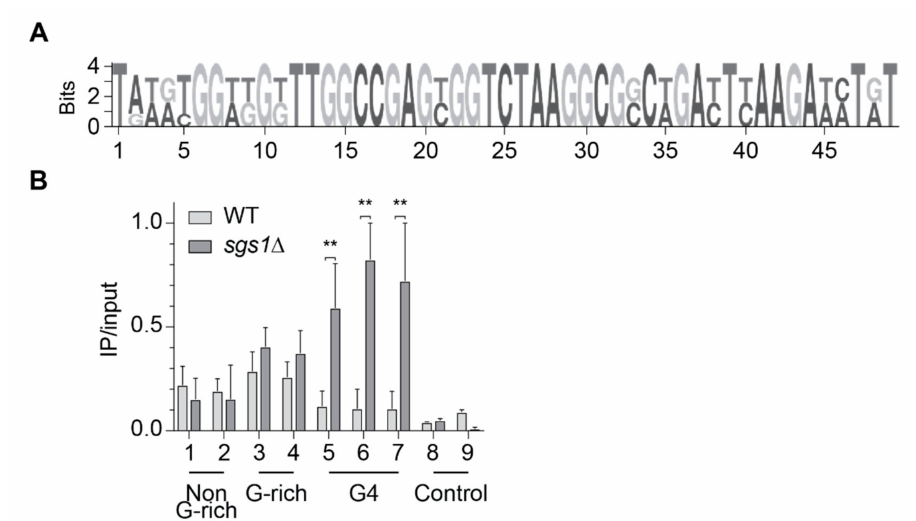
Figure 2. Slx9 binds, genome-wide, to G-rich regions. ( A ) Using Slx9-Myc, two independent ChIP-seq analyses were obtained. Peaks were called using MACS 2.0. A G-rich binding motif was obtained by MEME using the mean of two independent Slx9-Myc ChIP-seq experiments. The binding motif was identified in ~16% of the peaks. ( B ) Slx9 binding was determined to nine endogenous regions (see Supplementary Materials S4 for primer information) by ChIP and qPCR analysis. Selected regions have been identified as binding and non-binding regions in ChIP-seq. Di ff erent sequence compositions were chosen for analysis: non-G-rich (binding) and G-rich (binding) sequences, G4 motifs (no binding), and control regions (no binding). G4 motifs contained G-tracts of 3 guanines, resulting in stable G4 structure formation under G4-forming conditions. G-rich sequences could adopt less stable G4 structures, if at all. Binding of Slx9-Myc was monitored in wild type (light) and sgs1 ∆ (dark) cells. Significance was calculated based on Student’s t -test (** p -value < 0.001). All depicted